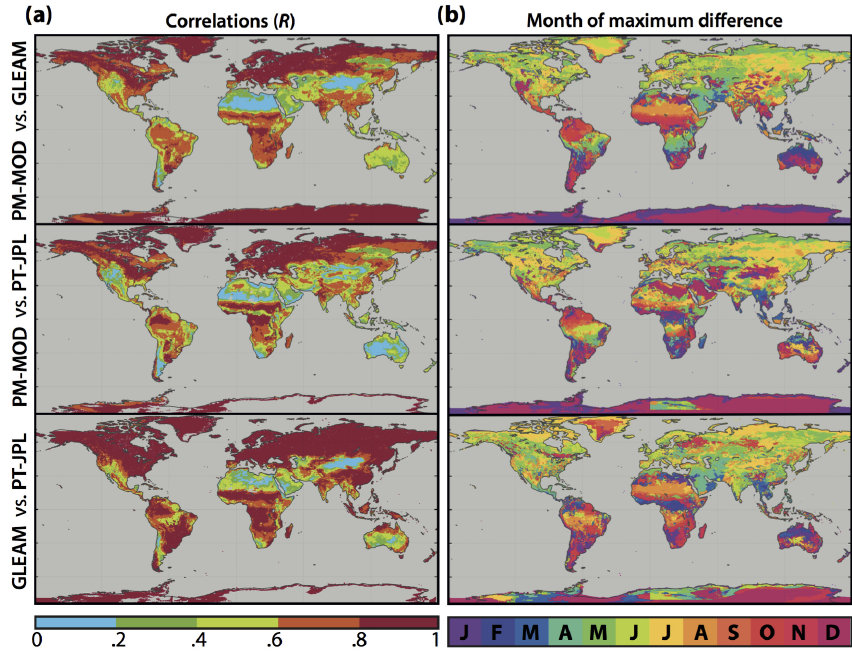
Figure 6. Temporal agreement between the models. Panel (a) : temporal correlation coefficients between each pair of products based on the daily (2005–2007) time series. Panel (b) : month of the year in which the maximum (monthly) difference occurs between a particular pair of products based on their monthly